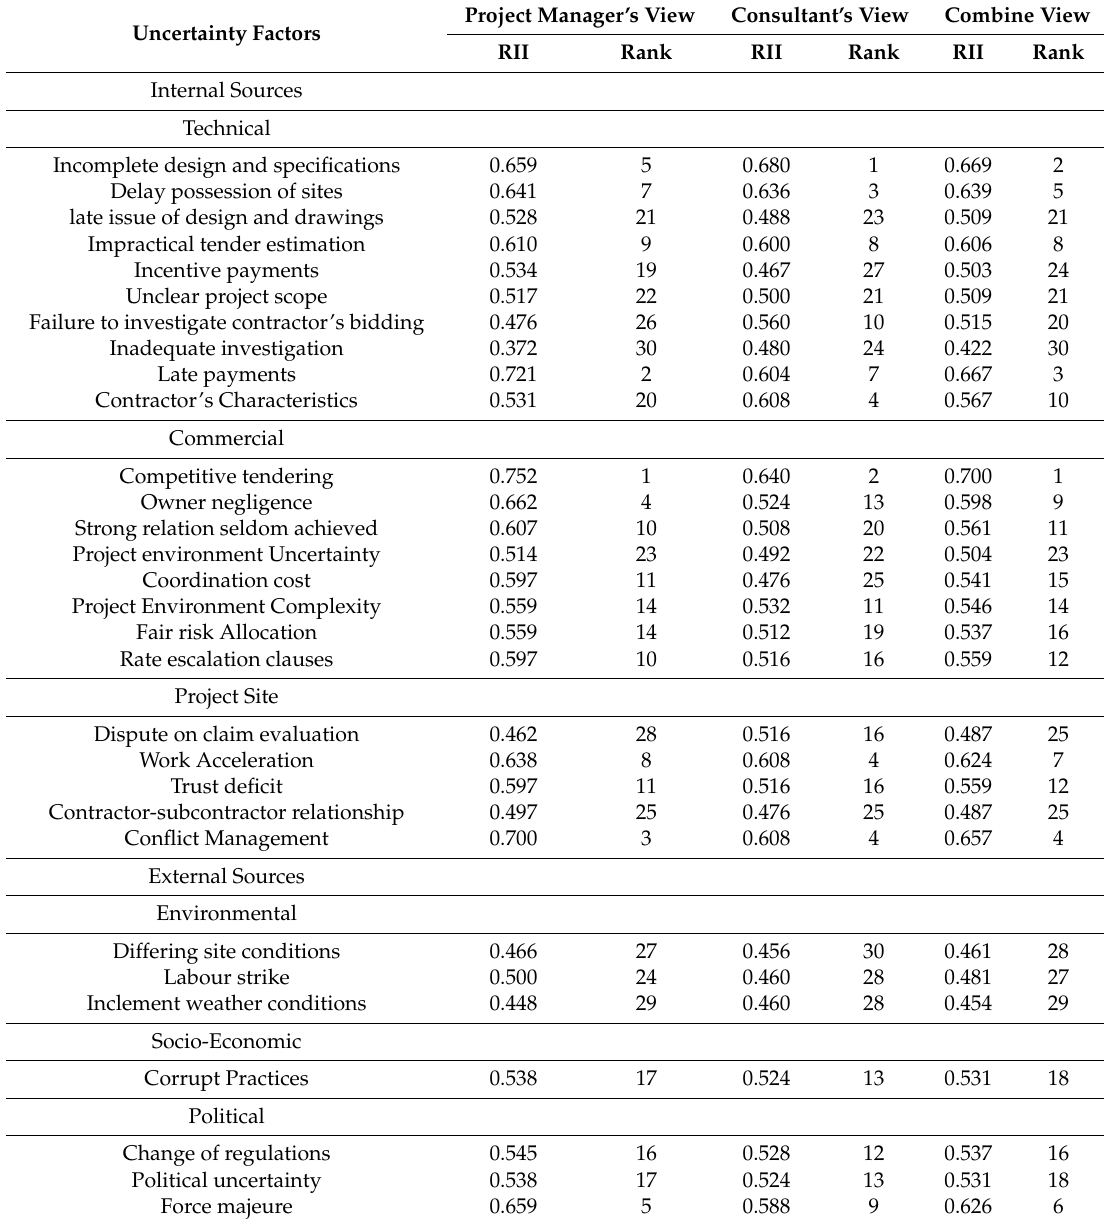
Table 3. Relative Importance Index Values and Ranking of Significant Uncertainty